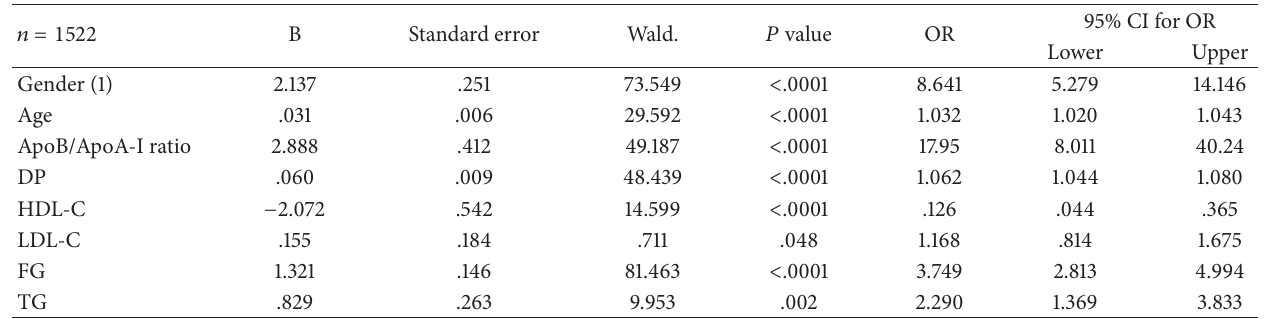
Table 5: Logistic regression models predicting insulin resistance.